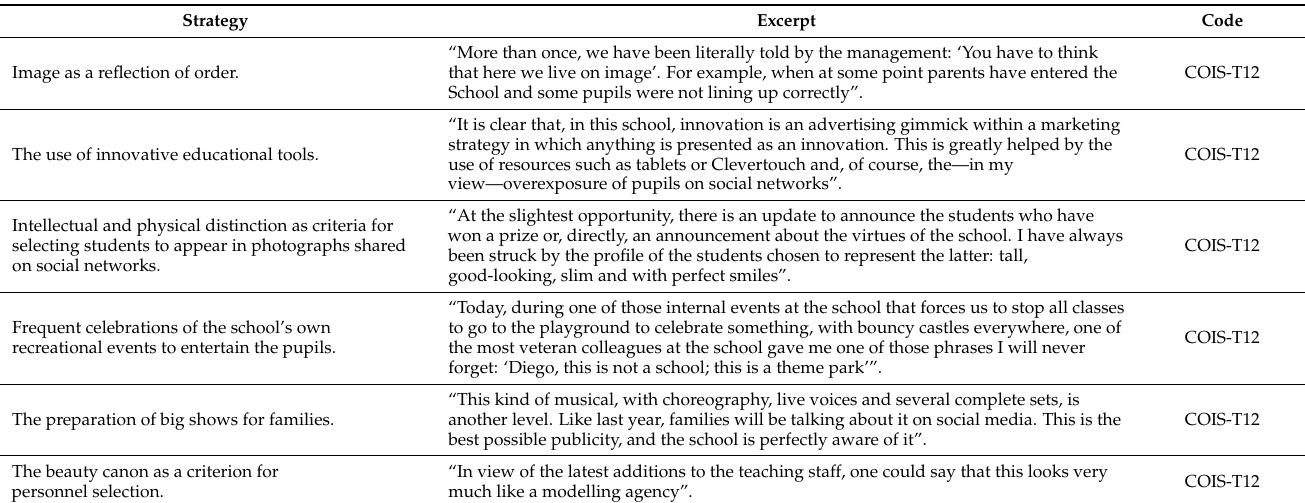
Table 7. Selected excerpts on the topic of the school’s competitive strategies from a teacher–researcher